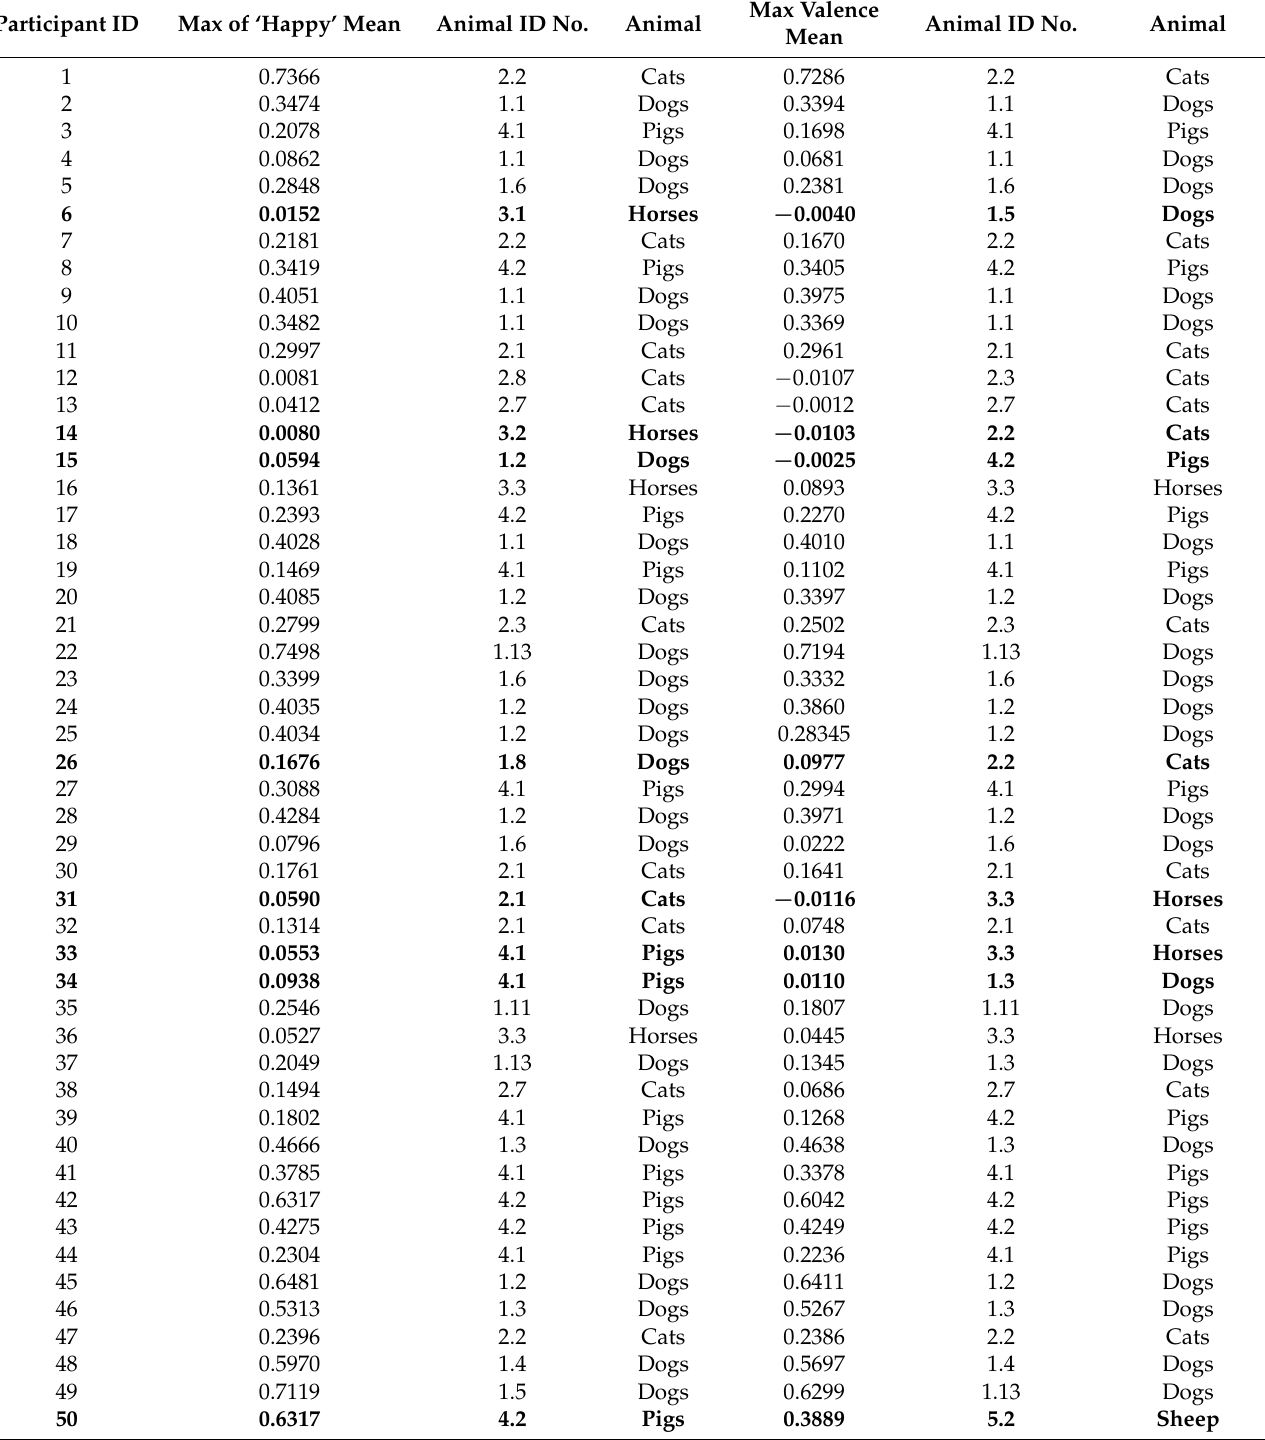
Table 4. Personalized selection of animal species and breeds for individuals, according to the animal species and breed-induced ‘happy’ and valence